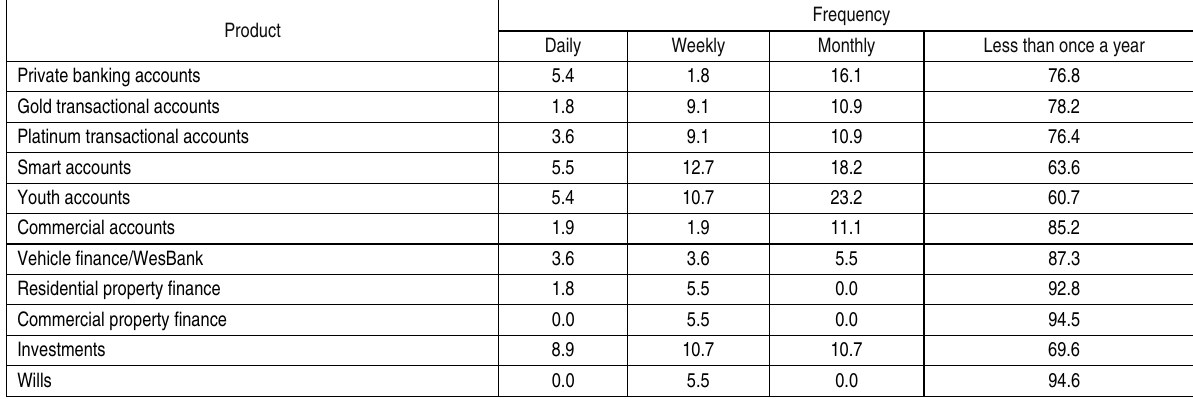
Table 3. Types and frequency of Islamic banking products and services sold